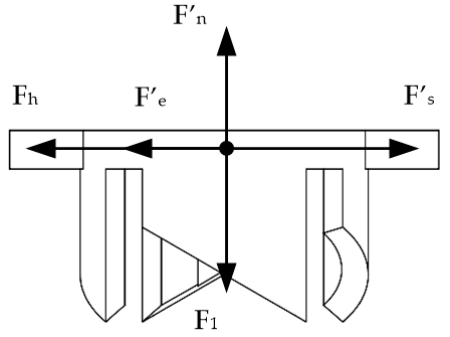
Figure 13 . Force diagram of ratchet. Figure 13. Force diagram of